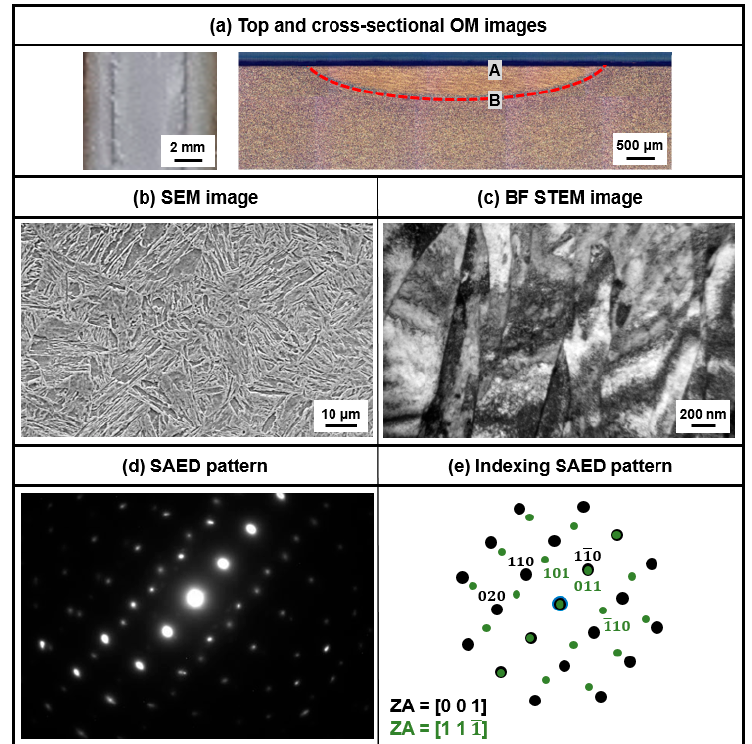
Figure 5. Microstructure of the LH P21 at the top surface (labeled as “A” in ( a )); ( a ) top- and cross-sectional optical microscopy (OM) image, ( b ) top-sectional SEM image, ( c ) bright field scanning transmission electron microscopy (STEM) image, ( d ) selected area electron diffraction (SAED) pattern for TEM image, and ( e ) the indexing of the SAED pattern.